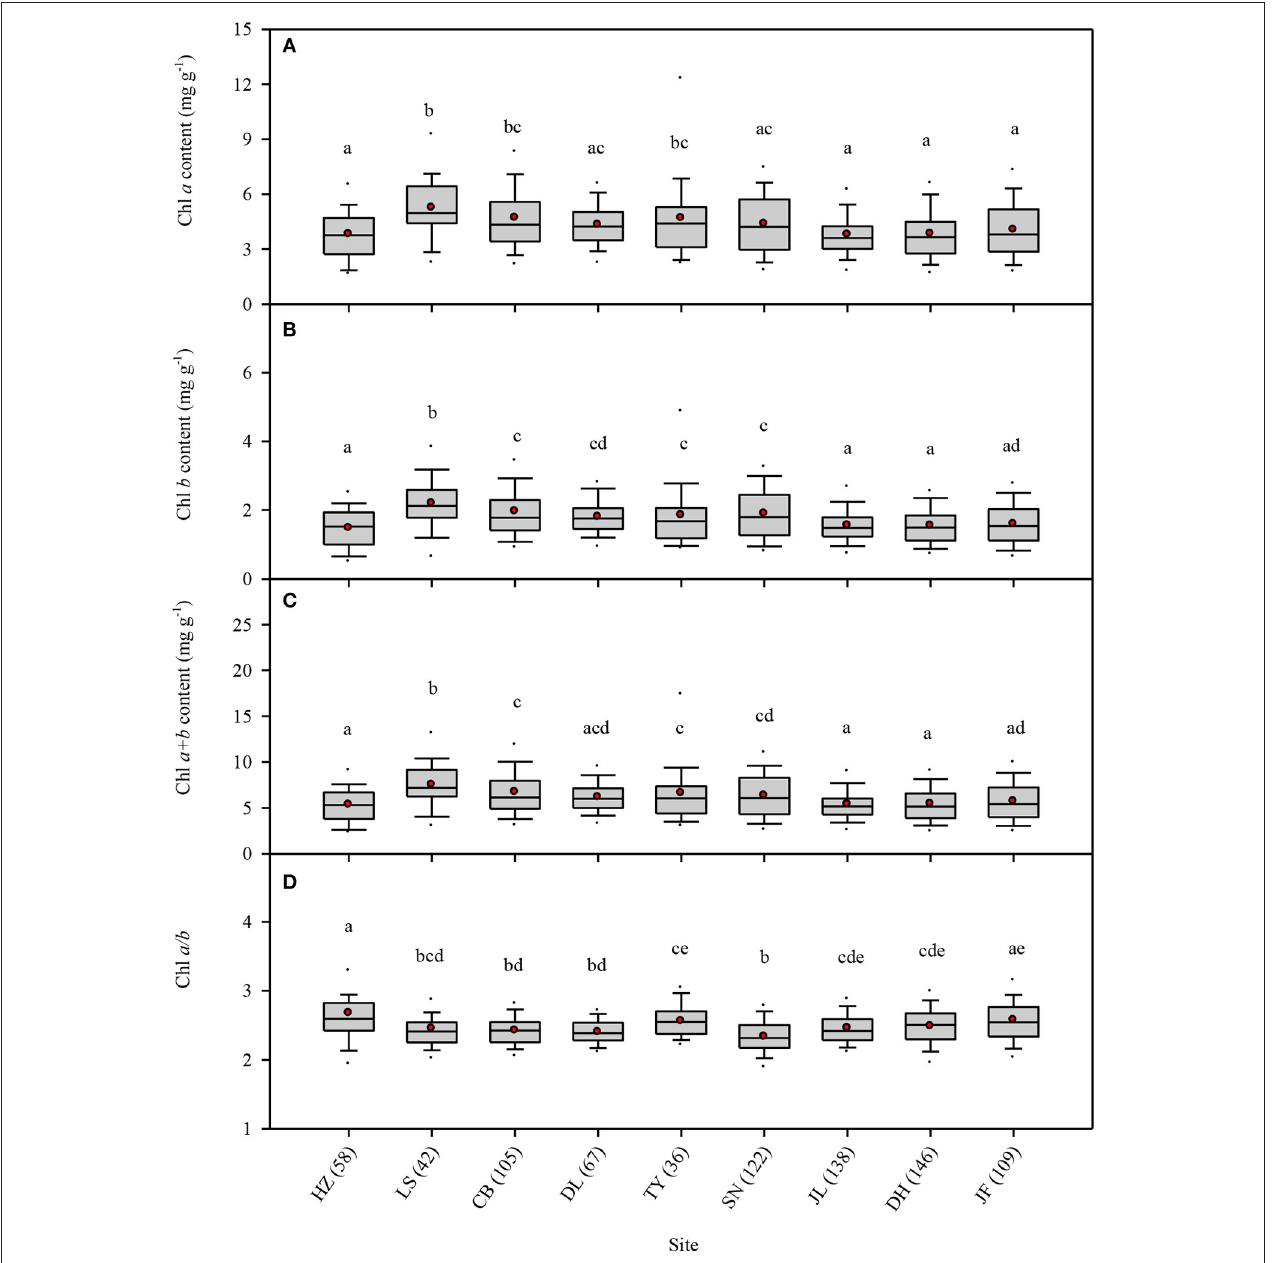
FIGURE 1 | Statistics of leaf chlorophyll content for the nine study forests along the North-South Transect of Eastern China (NSTEC). (A–D) were calculated in Chl a , Chl b , Chl a + b , Chl a/ b , respectively. The black lines across the boxes are median values and red points represent the means. HZ, Huzhong; LS, Liangshui; CB, Changbai; DL, Dongling; TY, Taiyue; SN, Shennongjia; JL, Jiulian; DH, Dinghu; JF, Jianfengling. Numbers in brackets represent the number of sample species in the specific site. Same letters denote no significant difference among the nine sites ( P <